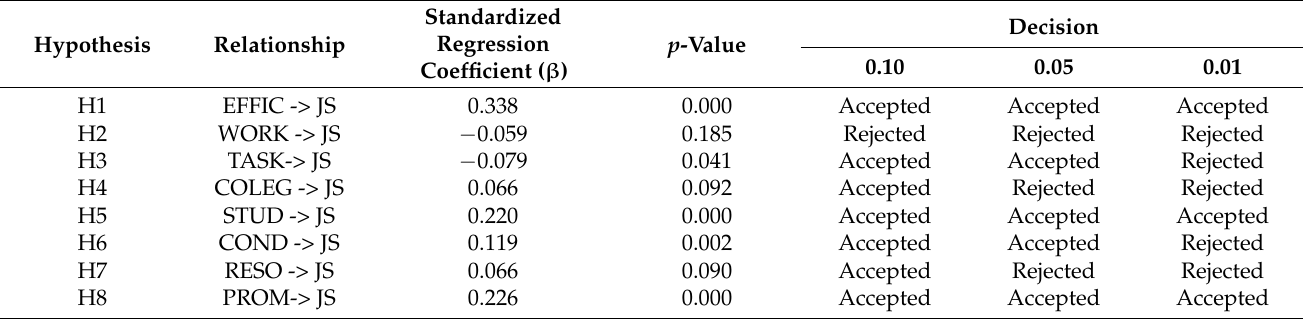
Figure 2. Estimates of the structural equation modelling. Table 5. Summary of the hypotheses’ testing